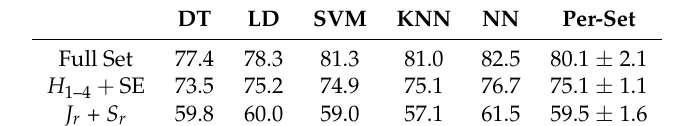
Table 4. Overall classification accuracies (%) for the full set, the spectral set and the stability set.